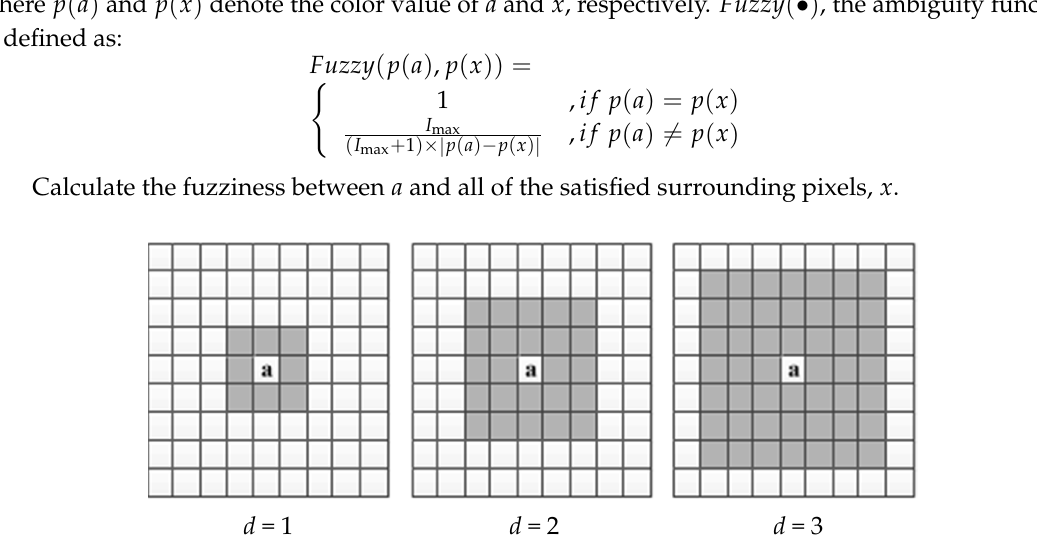
Figure 3. Determination of surrounding pixels x for a given pixel a when d is set as d = 1, d = 2, and d = 3, separately. d = 3,